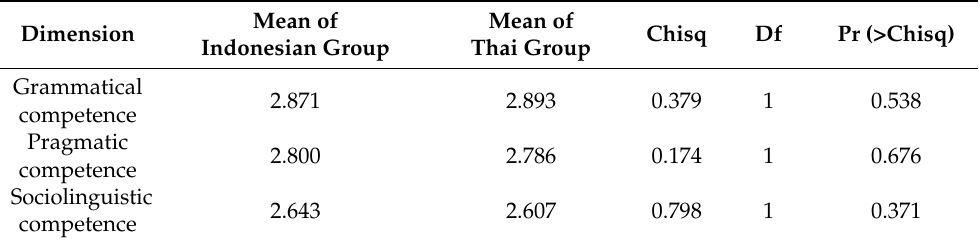
Table 2. Statistical results of L2 proficiency self-assessment between the Indonesian group and the Thai group. Mean of Dimension Indonesian Group Grammatical